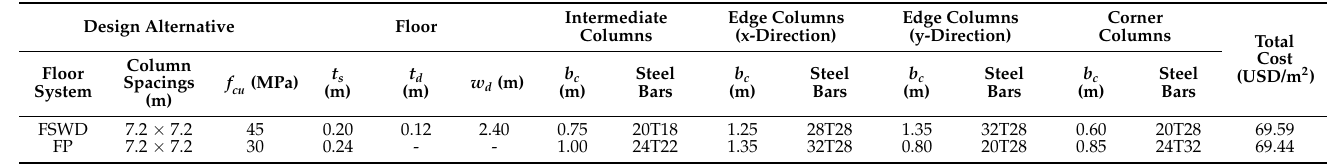
Table 6. Design parameters of the best design alternative for each floor